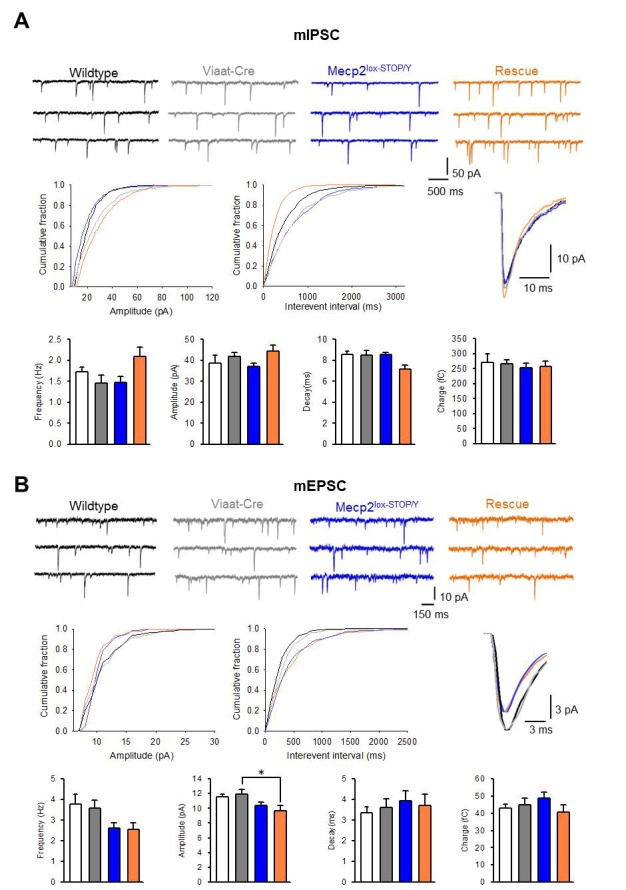
Inhibitory signaling in rescue mice showed some improvement while excitatory signaling was unchanged.(A–B) Sample traces of mIPSC (A, Wildtype = 11, Viaat-Cre = 17, Mecp2lox-STOP/Y = 14, Rescue = 11) and mEPSC (B, Wildtype = 17, Viaat-Cre = 16, Mecp2lox-STOP/Y = 18, Rescue = 17) from pyramidal cells of the somatosensory cortex of wildtype, Viaat-Cre, Mecp2lox-STOP/Y, and Rescue male mice, including cumulative distributions of amplitude and interval, grand average minis, and summaries of frequency, amplitude, decay, and average charge. Error bars show SEM. *p<0.05DOI: